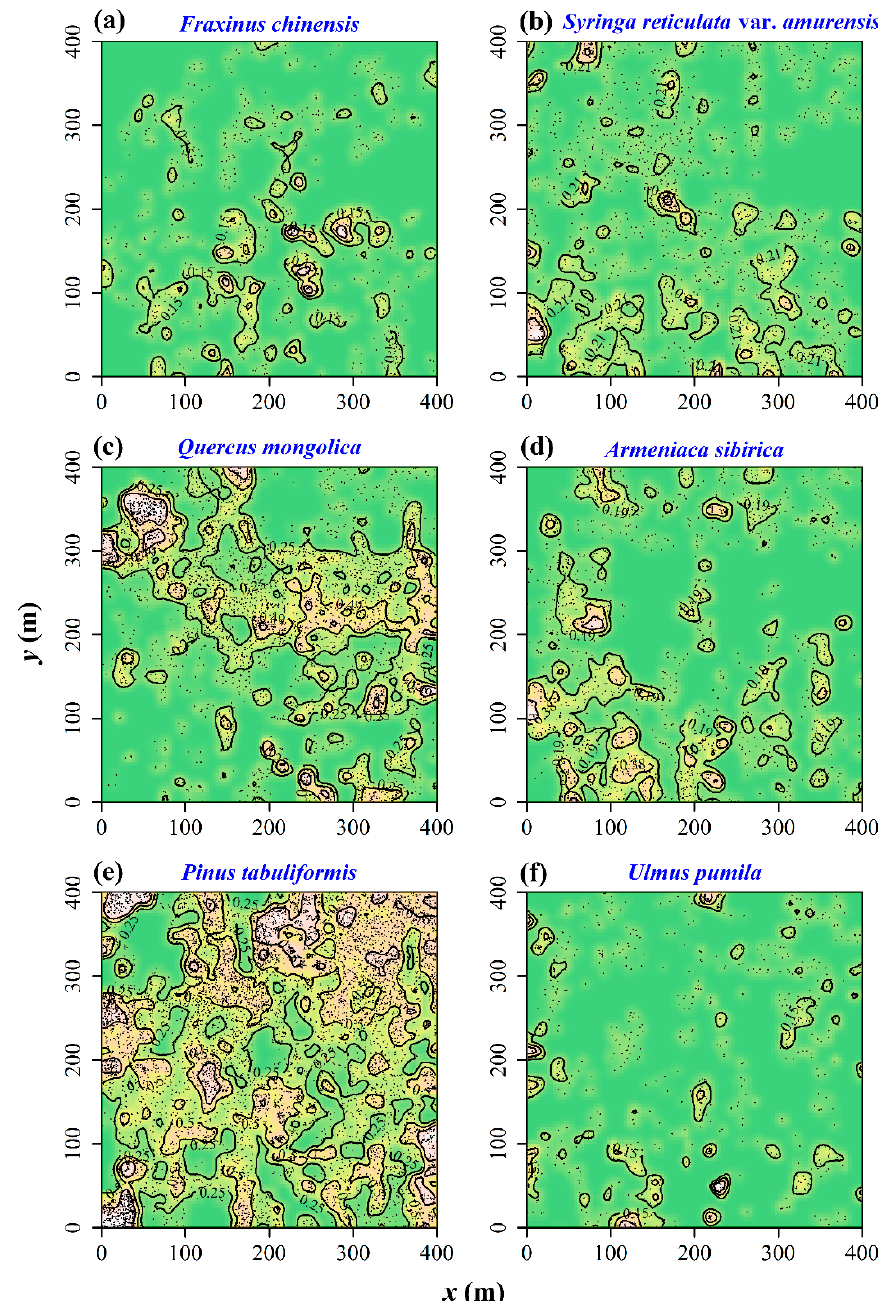
Figure 3. The type-specific probabilities of six dominant tree species. In each panel, the brighter the color is, the higher the type-specific probability is. There are some isolines of the type-specific probabilities. ( a ) F. chinensis ; ( b ) S. reticulata var. amurensis ; ( c ) Q. mongolica ; ( d ) A. sibirica ; ( e ) P. tabuliformis ; ( f ) U. pumila .